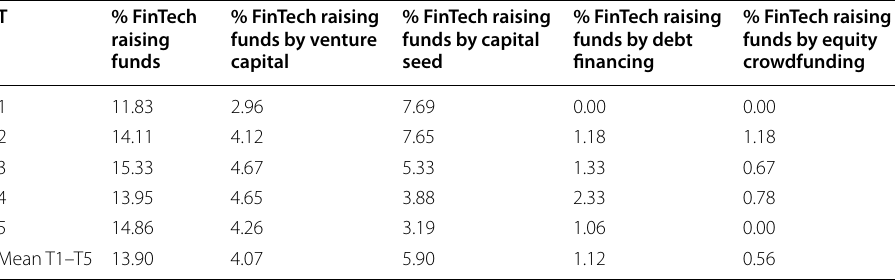
Table 6 Summary statistics of FinTech companies receiving funds by date of foundation T % FinTech